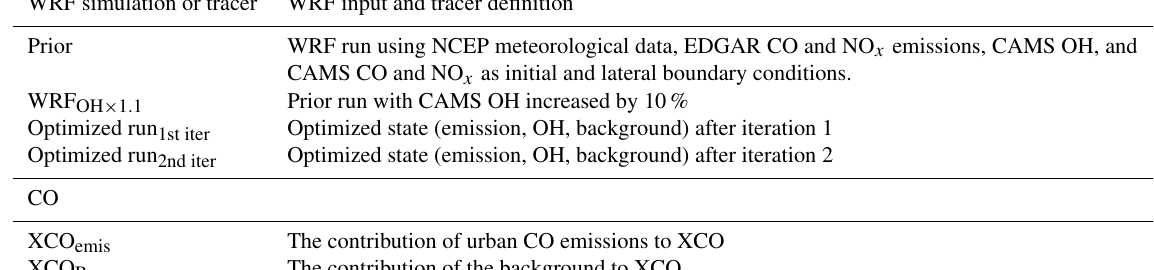
Table 1. Summary of WRF simulations and the definition of tracers and acronyms used. WRF simulation or